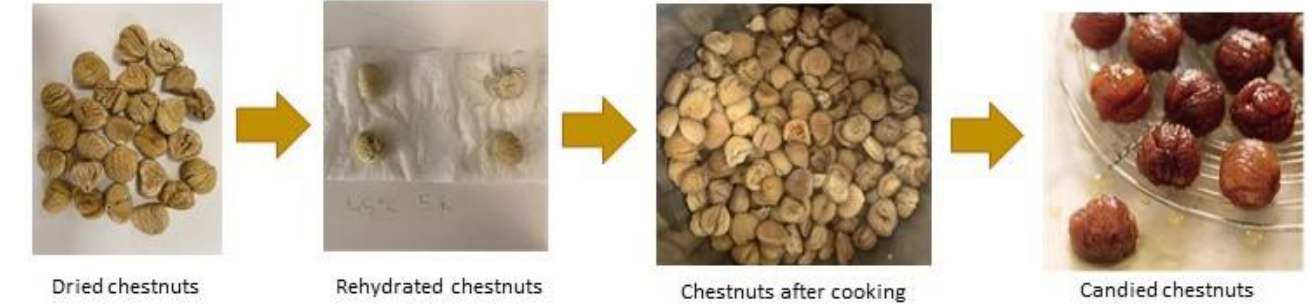
Figure 4. Martainha Chestnuts at different stages of processing.